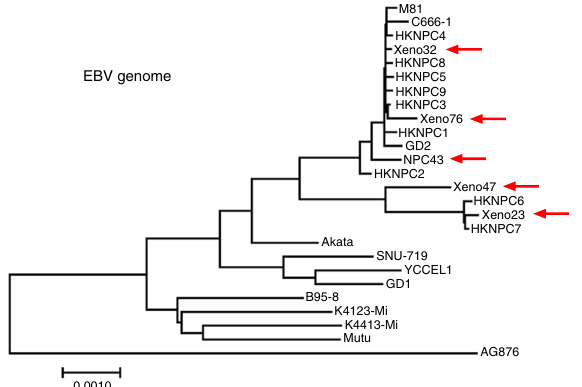
C for 10s, annealing and elongation at 60°C for 30s. PCR was performed on serial dilutions of Namalwa DNA (harboring two EBV per genome) to generate two individual calibration curves for EBNA1 and β -globin 40,41 . The average EBV copy number per cell was calculated according to the standard calibration curves prepared from Namalwa DNA. (Invitrogen) and SuperScript ® First-Strand Synthesis System for RT-PCR (Invi- trogen), respectively, according to the manufacturer ’ s protocols 42 . Expression levels of EBV transcripts were examined by real-time PCR. The primers and probes for different genes were designed using Universal Probe Library System as listed in Supplementary Table 7. The expression levels of EBV genes were normalized to